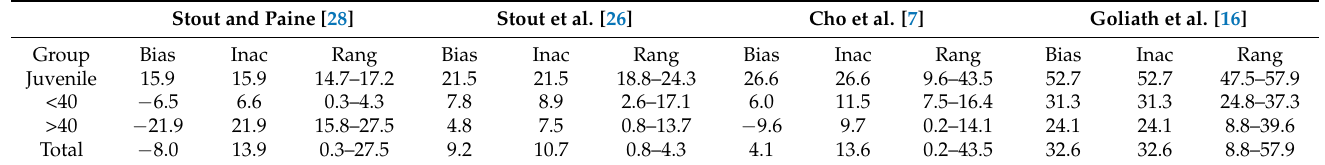
Table 6. Bias, inaccuracy, and absolute error range for the age estimates of the rib sample divided by age group.